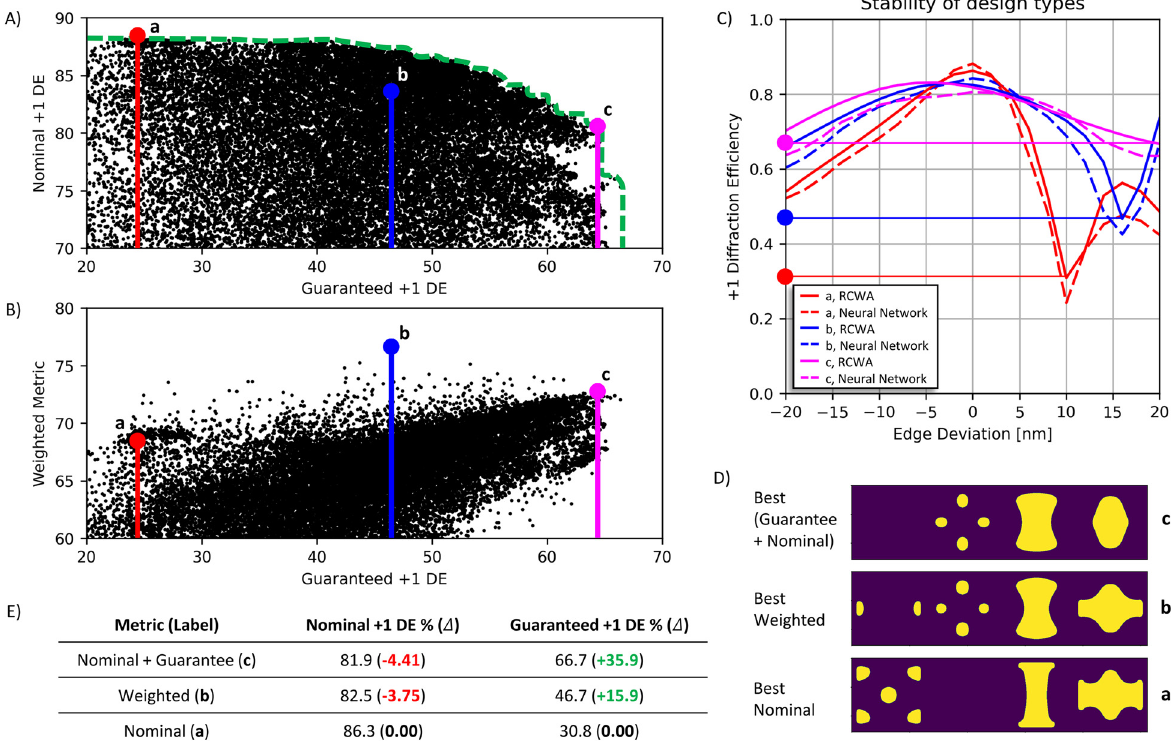
Figure 4: Robustness tradeoff analysis. (A)Multiobjectivestudyofsupercellnominalperformanceversuslossunder ± 20nmofperturbation.Thenominalperformanceofeachdesign is the y -axis, and the guaranteed performance is the x -axis. The Pareto front is marked with a dashed green line — an ideal design would lie in weighted,andbestguarantee + nominal,respectively.(B)Replottingthesamplesfrom(A)withanew y -axisnowshowingtheweightedmetric. (C) Comparison of edge deviation curves for options a, b, and c, including prediction made by DNN and validation from RCWA solver. Paying